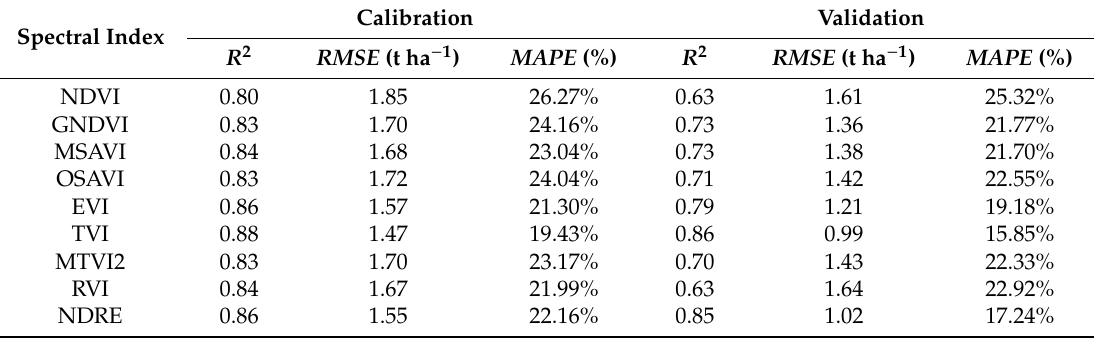
Table 4. Calibration and validation results for the cotton biomass estimation models designed using the spectral indices. During model calibration, linear, logarithm, exponential, and power models were used to design the model, with the best results shown